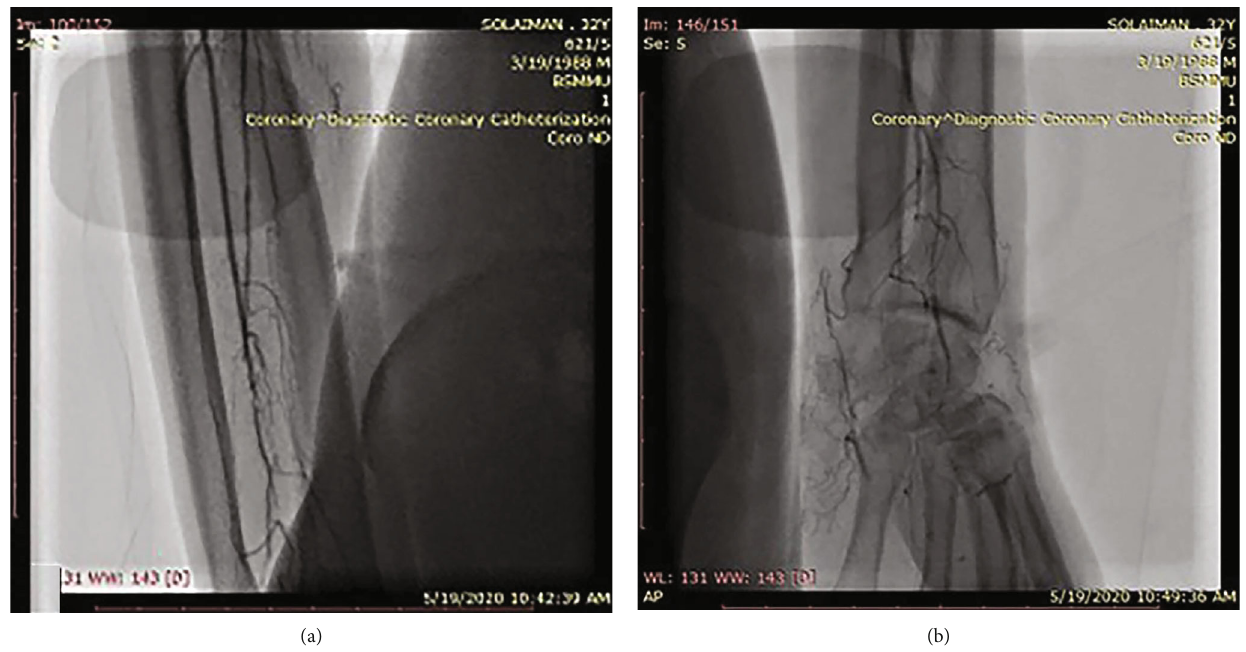
Figure 5: (a) Right ulnar artery nonvisualized from the midforearm and signi fi cant occlusion of the radial artery at the distal forearm; (b) distal ulnar and radial arteries are nonvisualized and very poor fi lling of the super fi cial palmar